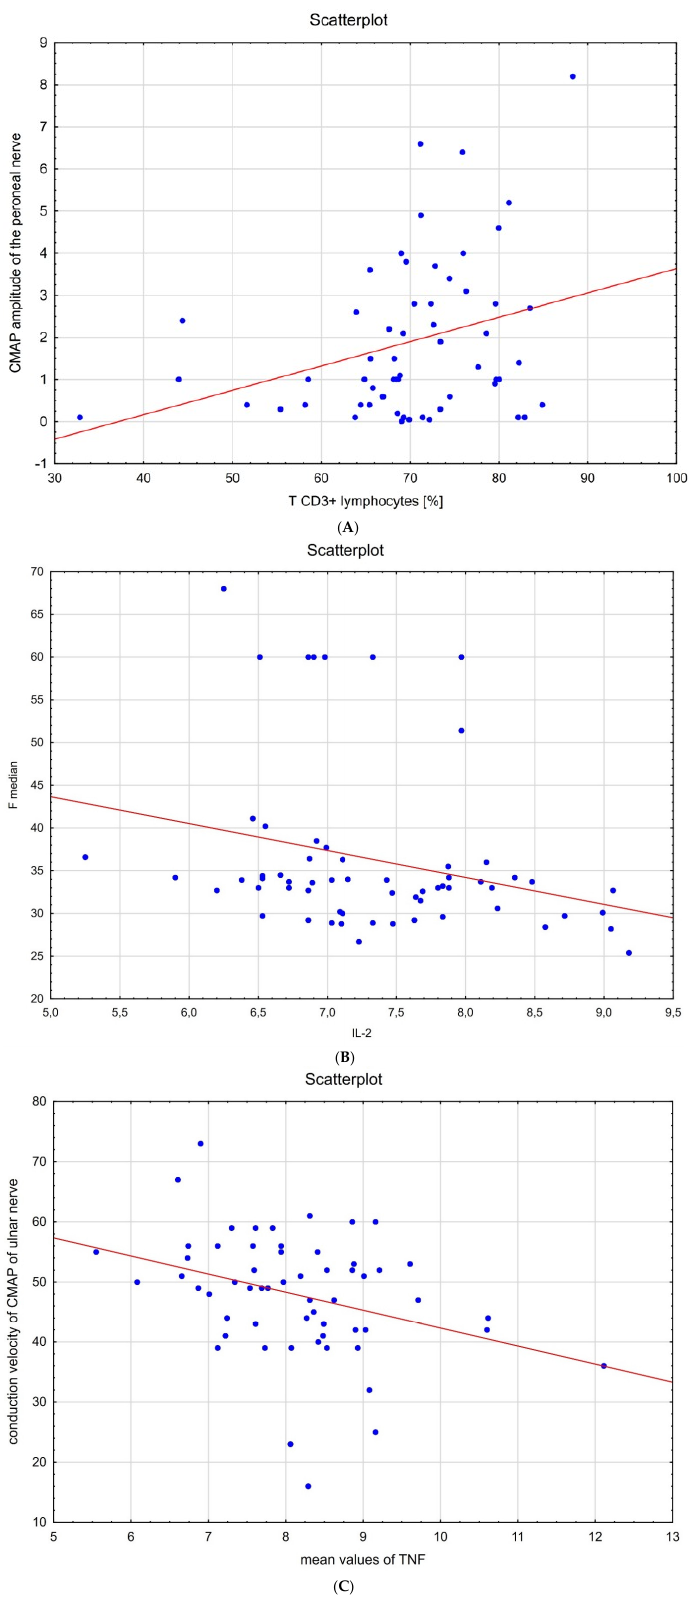
Figure 2 shows examples of three scatter plots: the percentage of CD3+ lymphocytes and CMAP amplitude of the peroneal nerve (positive correlation); serum TNF- α levels and motor conduction velocity in the ulnar nerve (negative correlation); and F-wave in the median nerve and IL-2 level (negative correlation).